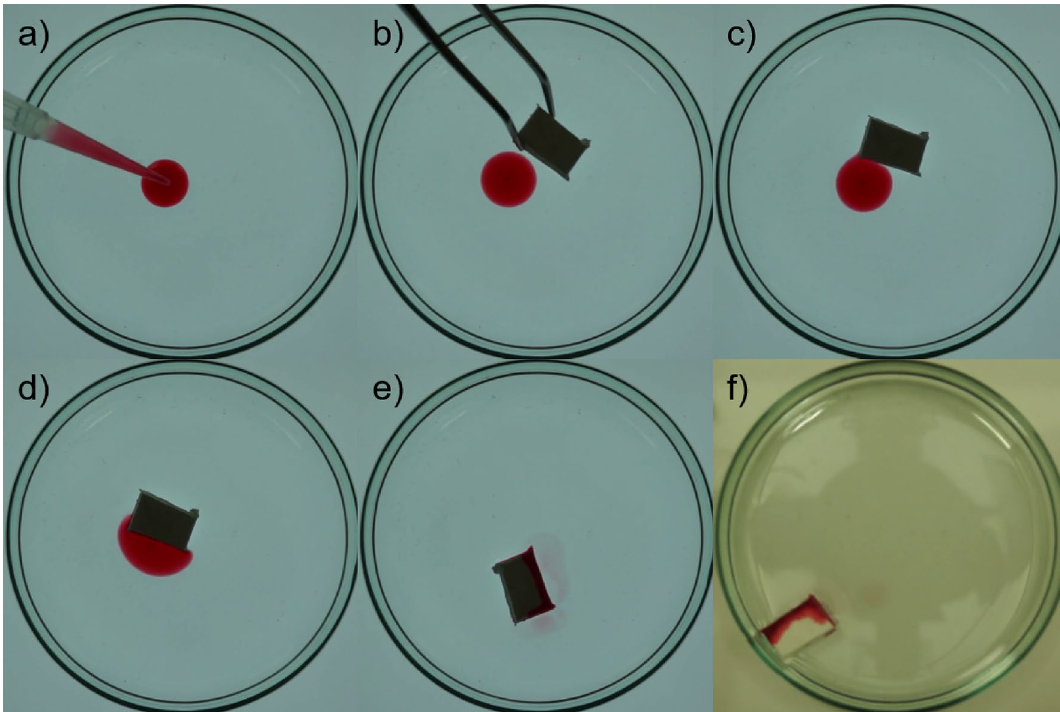
Figure 7. A 200 μl droplet of paraffin oil stained with the dye Oil red O added to a water surface inside a 9 cm Petri dish was absorbed within 4 minutes by a polypropylene foam with the dimensions 0.5 × 1 × 1.5 cm. The foam was made from 45% camphor, 45% camphene and 10% polypropylene mixture and camphor and camphene were removed completely. Frames ( a – e ) are back lit for better contrast and show snapshots of “foam- abs.avi” (See SI) at progressing non-even time intervals. Frame ( f ) was taken at the end of the experiment to show that the oil along with the stain has been absorbed by the foam